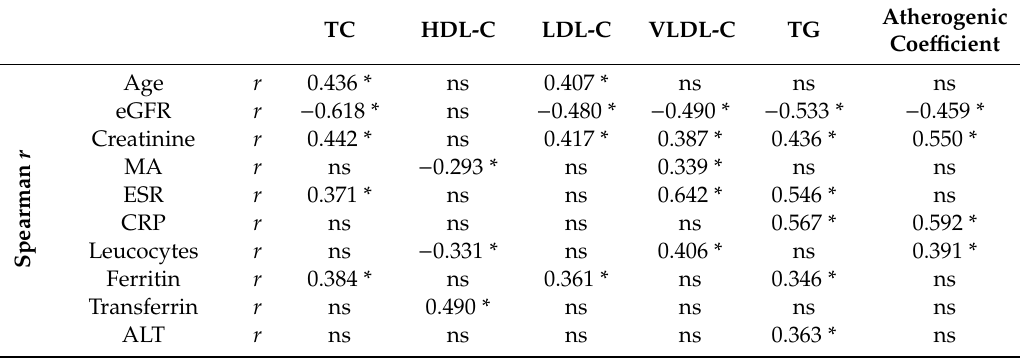
Table 6. Correlations between lipid profile, inflammatory markers and parameters of iron metabolism in patients with type 1